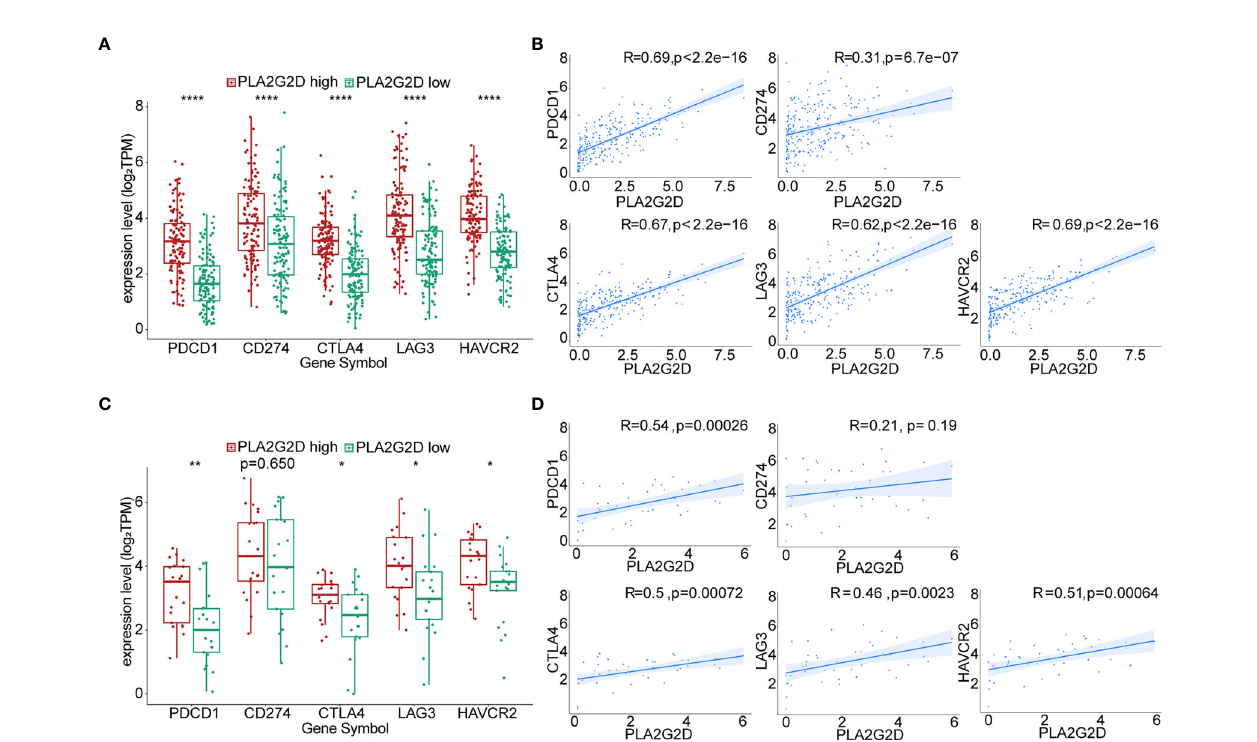
FIGURE 8 | Correlation of the expression level of PLA2G2D and ICPs. Histograms showing the comparison of ICP expression level between PLA2G2D -high and PLA2G2D -low groups in TCGA (A) and CGCI database (C) . Pearson correlation analysis for the expression level of PLA2G2D and ICPs in TCGA (B) and CGCI (D) database. * P < 0.05, ** P < 0.01, and **** P <